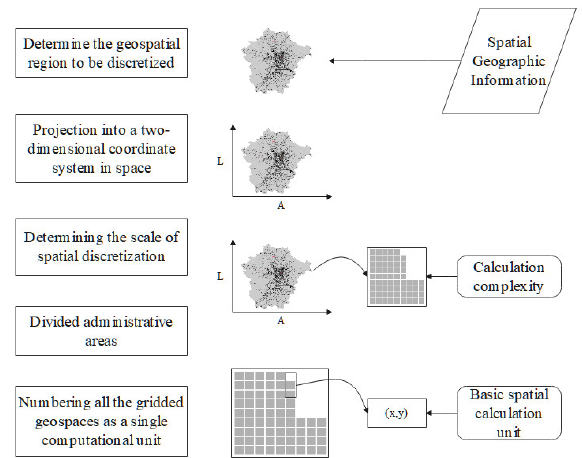
Figure 2. Geospatial discretization process.